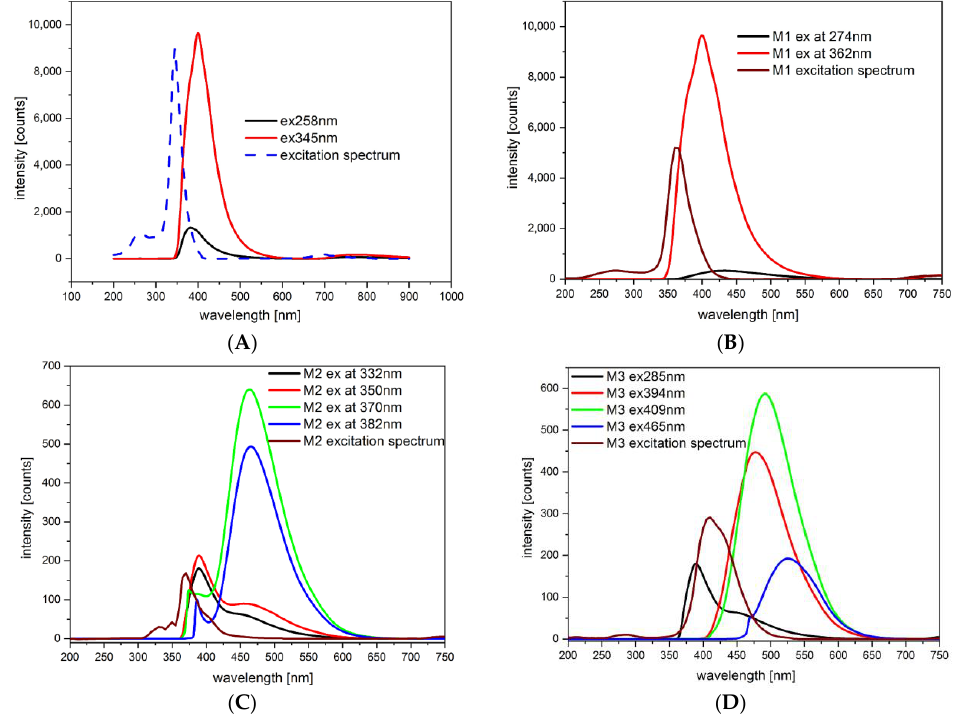
× 10 − 5 M). 2 Cl 2 (c = 1